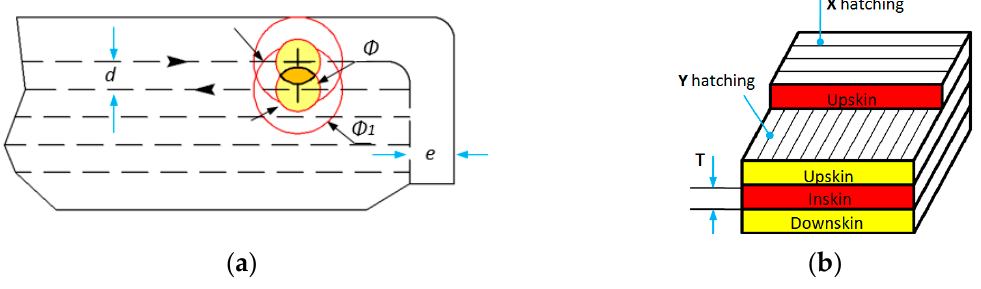
Figure 3. Geometrical aspects of laser spot and building layers. ( a ) laser trajectories and overlapping of the focal spot; ( b ) scanning strategies and layer types.